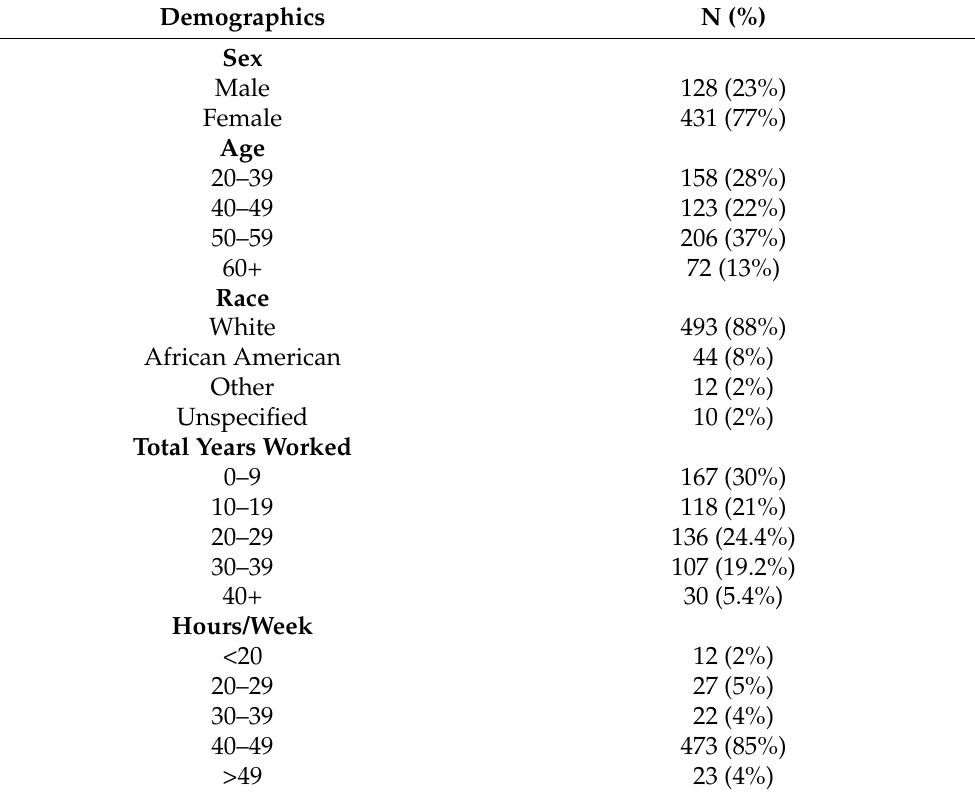
Table 1. Participant characteristics, N